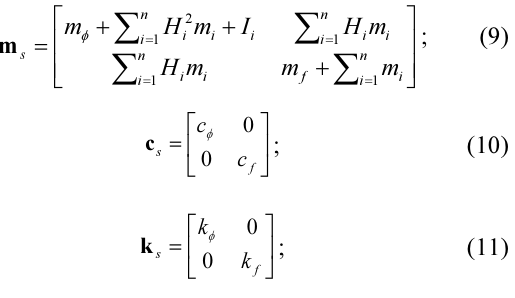
Table 1. Values for SSI parameters (Mulliken, Karabalis 1998) mass damping